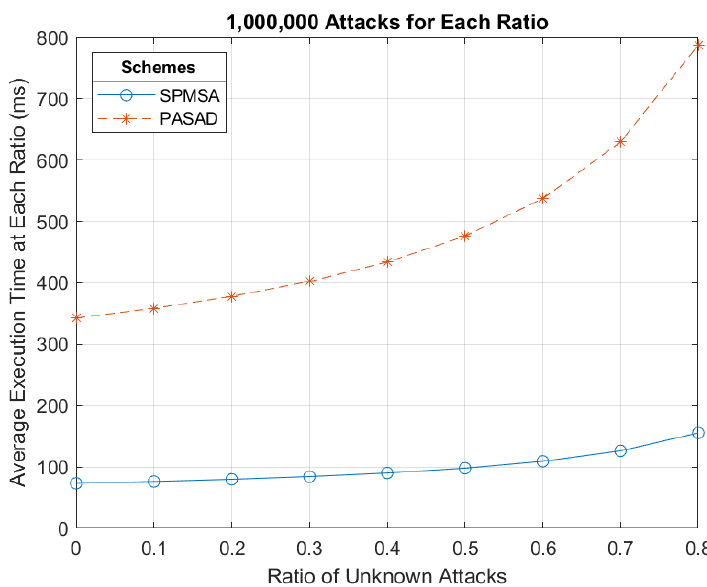
Figure 15. Performance of the Two Schemes against Unknown Attacks.